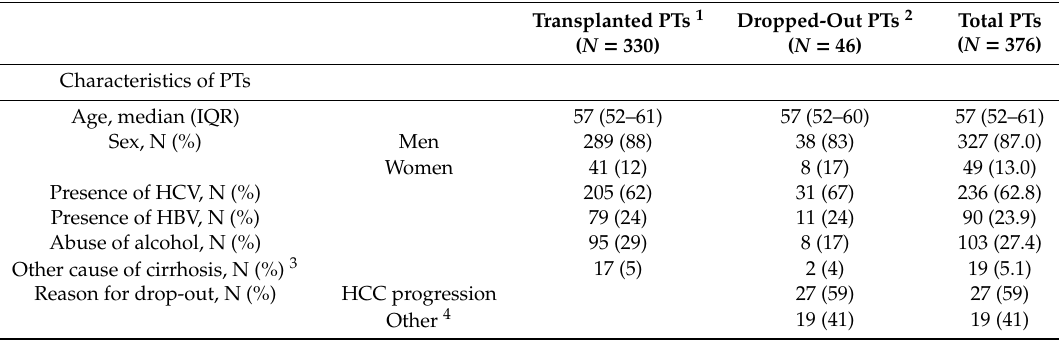
Table 1. Listed patients’ characteristics ( N =